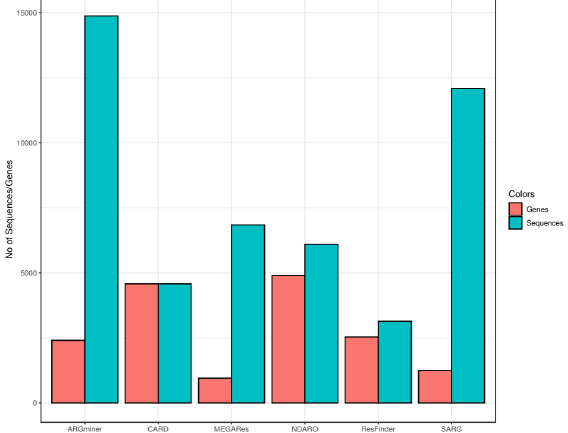
Figure 1. ARG and sequence content of the databases. Only antibiotic and biocide resistance genes were considered for the plot. For each database on the x axis, the number of unique sequences and the corresponding number of unique genes were determined. The y axis represents the number of genes and sequences. Red bars show the gene number while blue bars represent the number of sequences stored in each database.